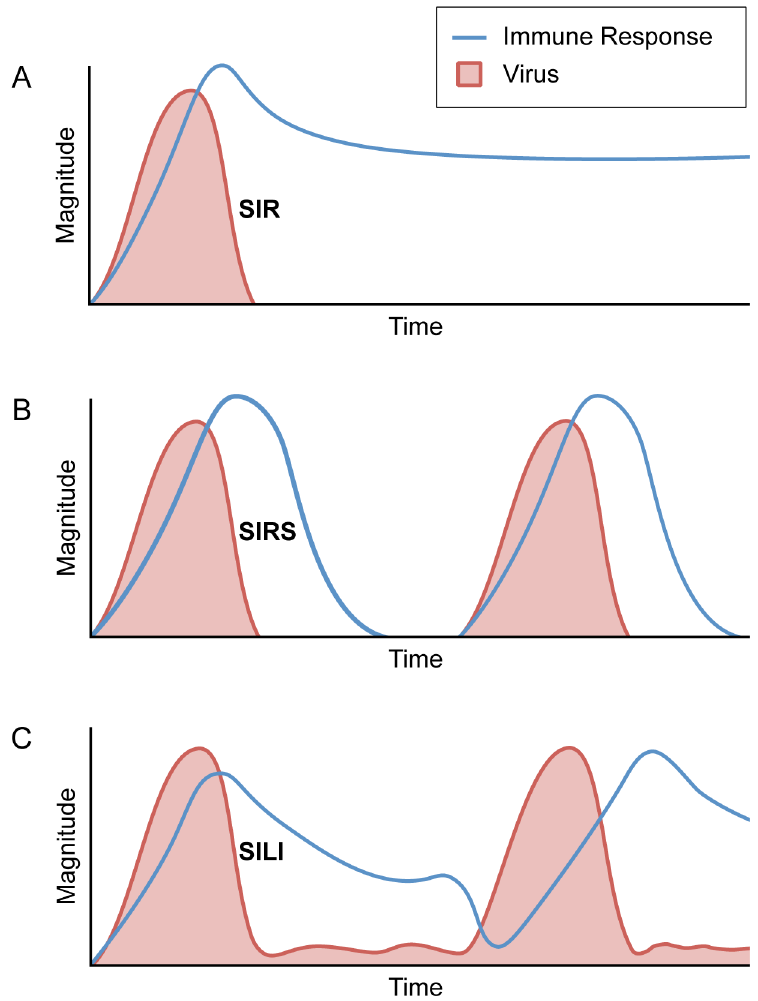
Fig 1. Within-host dynamics. Three working hypotheses represent the range of expert opinion about the dynamics of emerging viruses within bats. (A) Following an initial acute infection, the virus clears completely and bats remain refractory to infection (susceptible-infectious-recovered [SIR]). (B) The virus clears completely, but the bats ’ immune response wanes over time, allowing individuals to be reinfected (susceptible-infectious-recovered-susceptible [SIRS]). (C) Following the acute phase of infection, a chronic infection remains, or the infection is latent and then reactivated (susceptible-infectious-latent-infectious